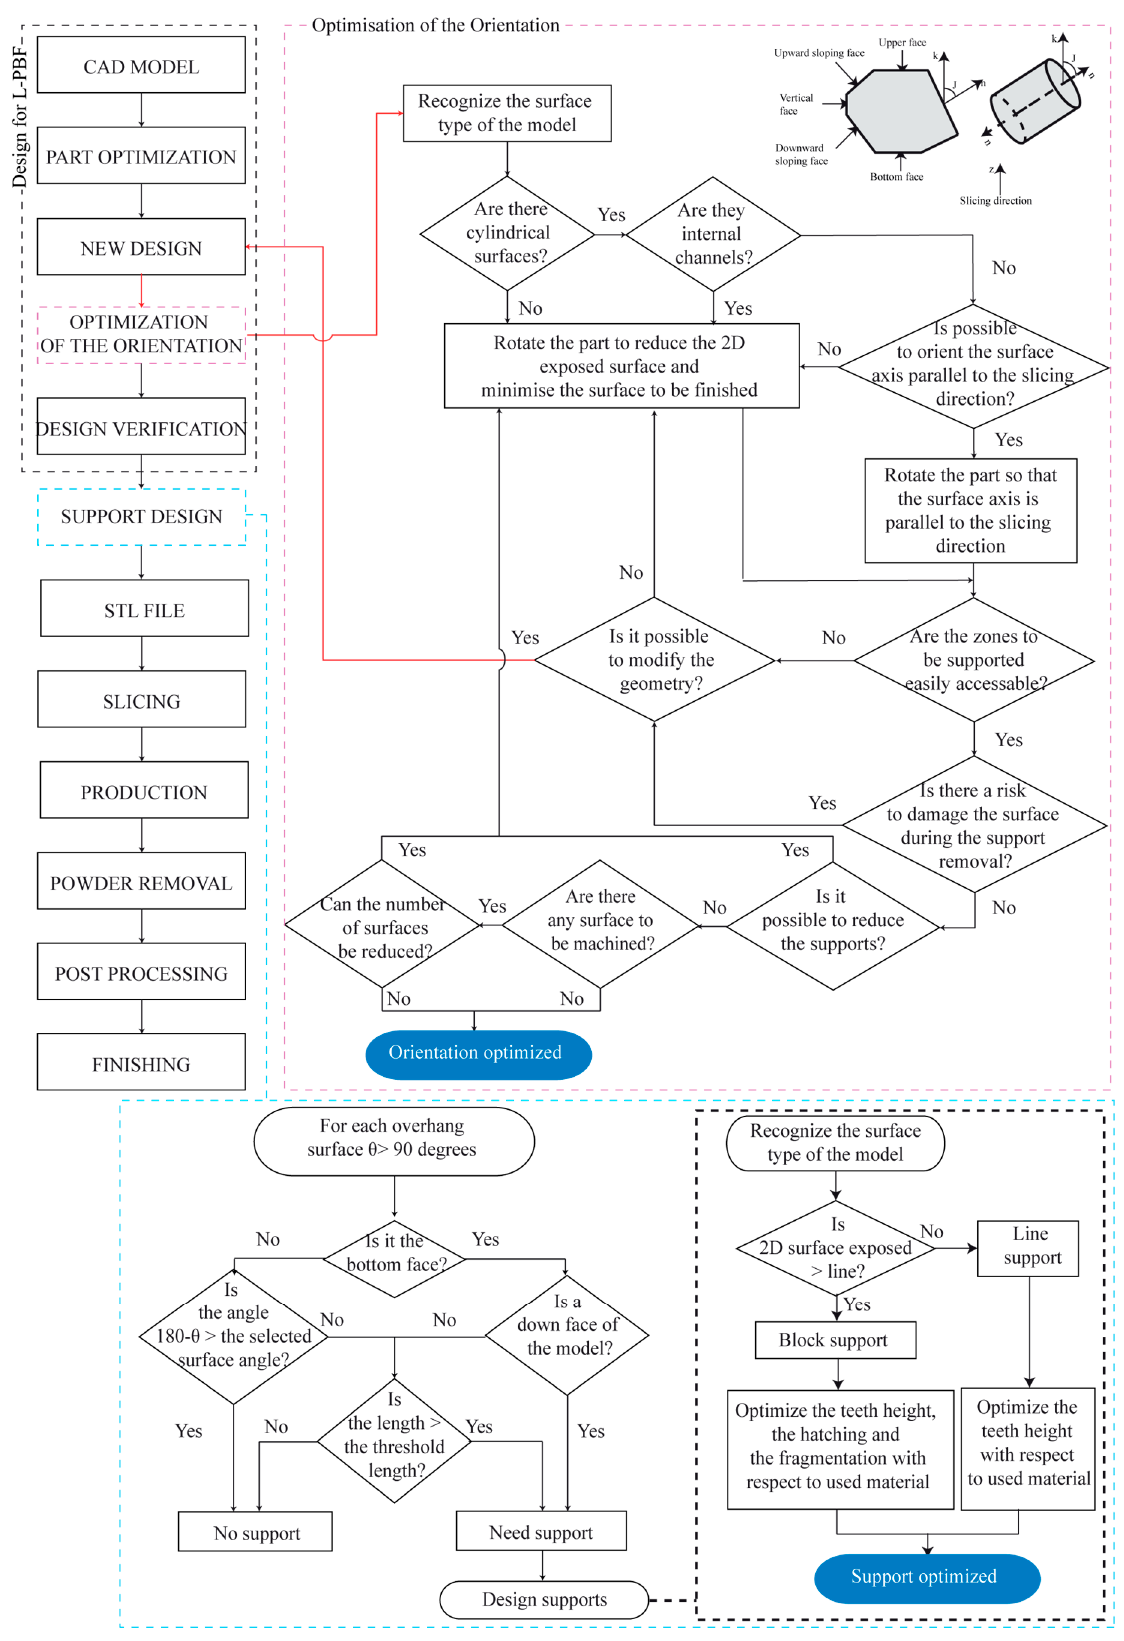
Figure 1. Design and manufacturing for an laser powder bed fusion (L-PBF ) process.